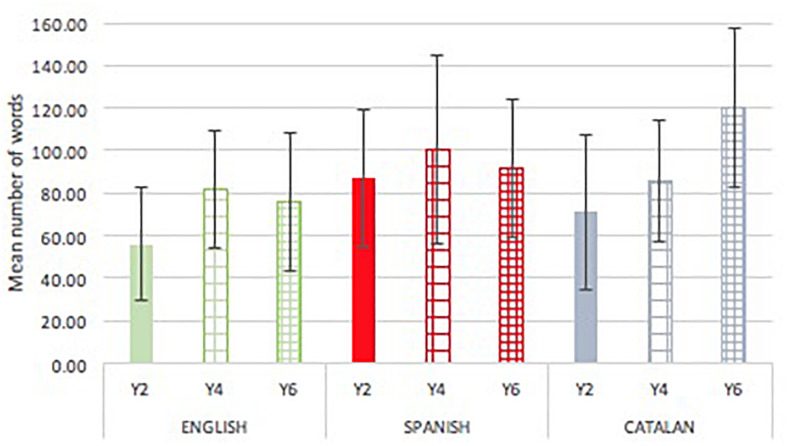
Mean (SD) text productivity (number of words) by language and school grade.